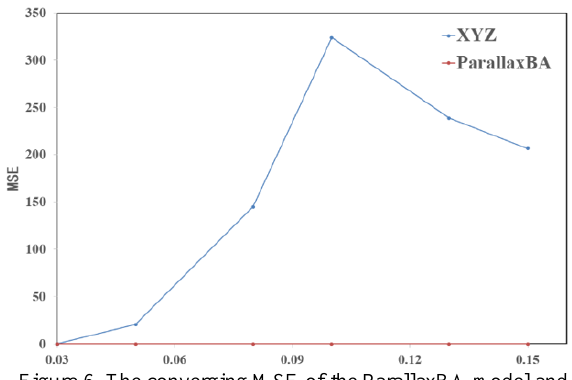
Figure 6. The converging MSE of the ParallaxBA model and the normal BA model (XYZ) given different initial values of camera angle